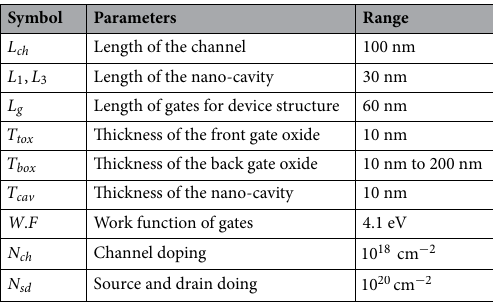
Table 1. Device parameters of the proposed structure.